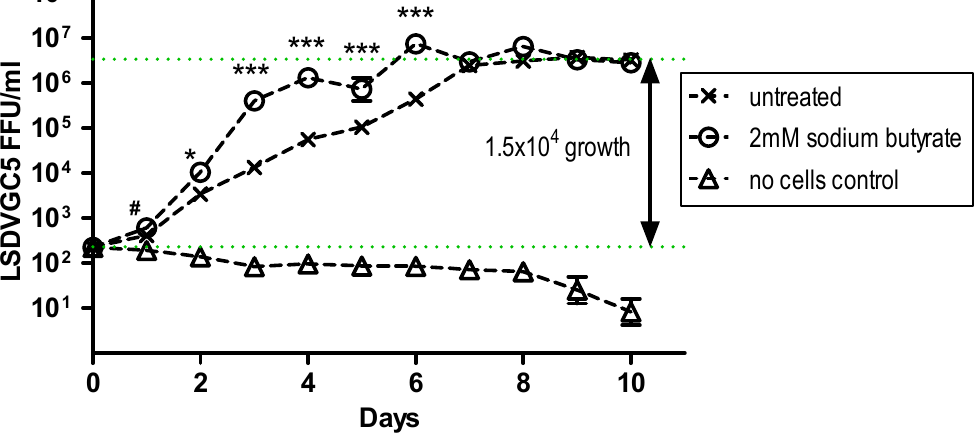
Figure 4. Growth of LSDVGC5 in BHK-21 cells in the presence and absence of sodium butyrate (SB). BHK-21 cells were infected at MOI = 0.5 ( n = 6). */***: untreated vs. SB ( p < 0.05 or 0.001 respectively), #: SB vs. no cells ( p < 0.05), untreated or SB vs. no cells ( p < 0.001) from day 2 to 10.